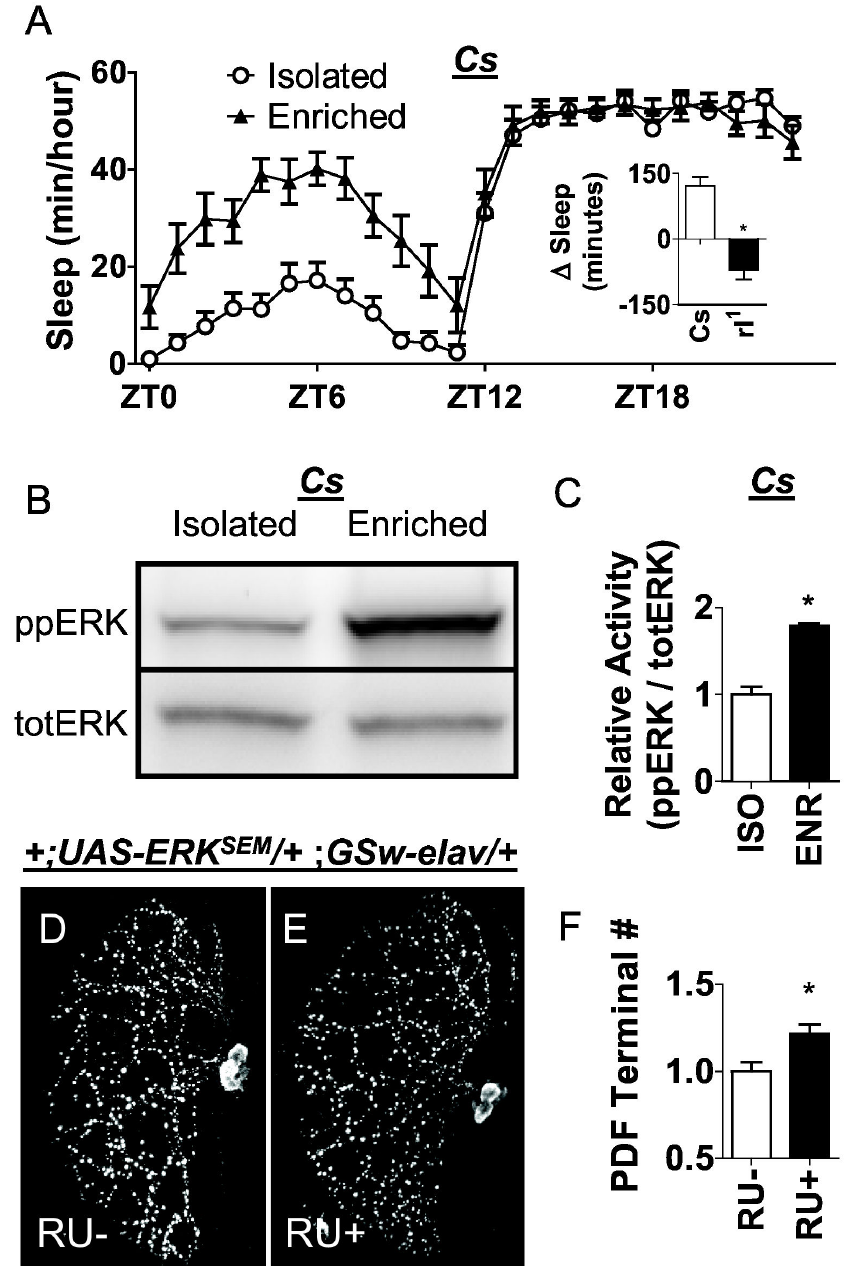
Figure 4. ERK increases structural plasticity. A , Cs flies exposed to 5 days of social enrichment with ~45 siblings display an increase in sleep compared to isolated controls. A 2(Isolated, Enriched) X 24 (Time (hour)) ANOVA reveals a significant condition x time interaction [ F = 5.044, P = 3.6E-13] (n = 16/ group). The inset shows that this increase in sleep following social enrichment (23,720) is attenuated in rl 1 mutant flies (shown as the change in sleep from the isolated siblings also known as ∆sleep). B , Representative Western blot showing that ppERK/totERK levels are increased in Cs flies following social enrichment compared to isolated siblings (4 heads per lane). C ) Quantification of the Western blot in B for ppERK/totERK reveal a statistically significant increase in ppERK/ totERK levels in the socially enriched group compared to isolated siblings p = 0.0002, student’s t-test. Data are presented as mean ± SEM (* = p < 0.05). D - E , Pan-neuronal expression of activated ERK in adult flies results in an increase number of PDF-positive terminals as revealed by immunohistochemistry. A representative image is shown for RU- fed + ; UAS-ERK SEM /+ ; GSw-elav/+ controls ( D ) and their RU+ fed experimental group ( E ). F , Quantification of terminal numbers reveals a significant increase in terminal number p = 0.0076, n= 11/group, student’s t-test. Values normalized vehicle fed controls. doi: 10.1371/journal.pone.0081554.g004 PLOS ONE |